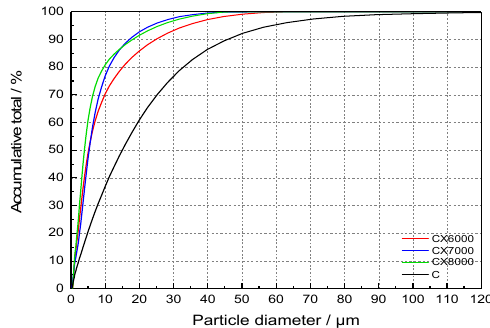
Figure 1. Cement particle size distribution.